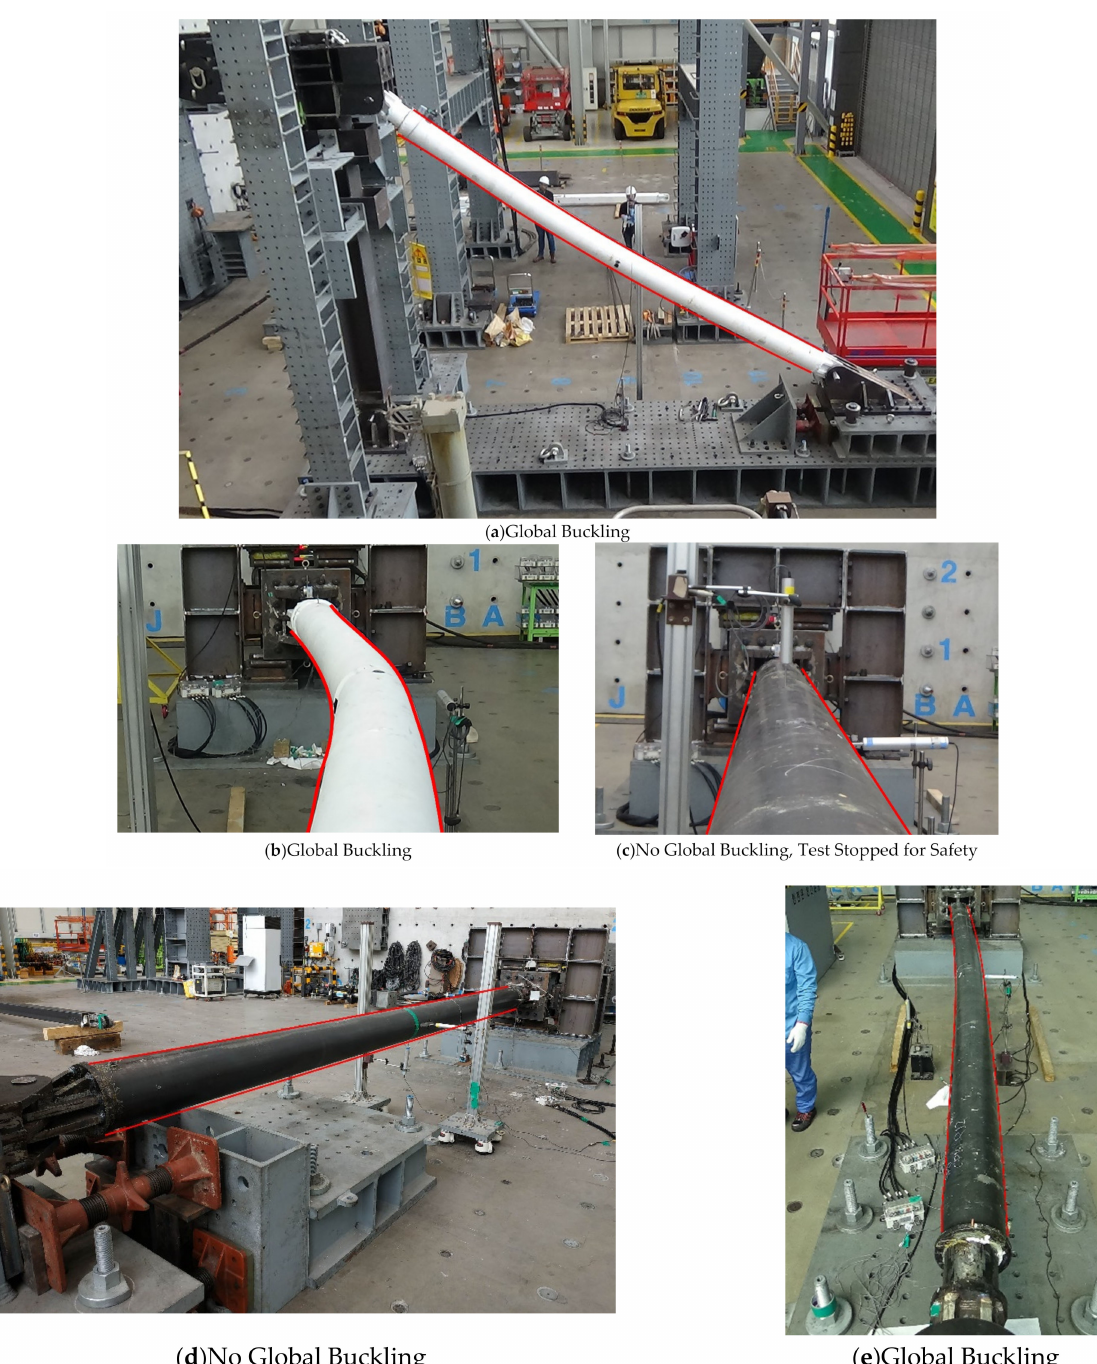
Figure 8. Deformed shape at the end of test: ( a ) C216 t8–C267 t6-S ; ( b ) C216 t8–C267 t6-B1 and C216 t8–C267 t6-B3 ; ( c ) C216 t8–C267 t6-B2 ; ( d ) C216 t6–C267 t6-B ; ( e ) C165 t7–C216 t6-B